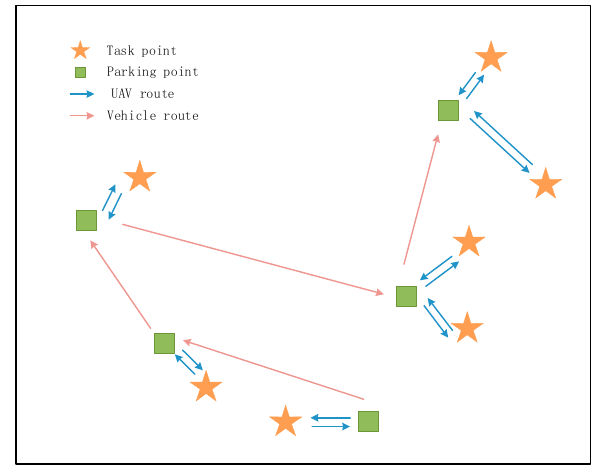
Figure 14. An illustration of the rule-based path planning (RBPP) algorithm. Table 4. Comparison of odd-even layered genetic algorithm (O-ELGA) and the RBPP algorithm in the different test instances.